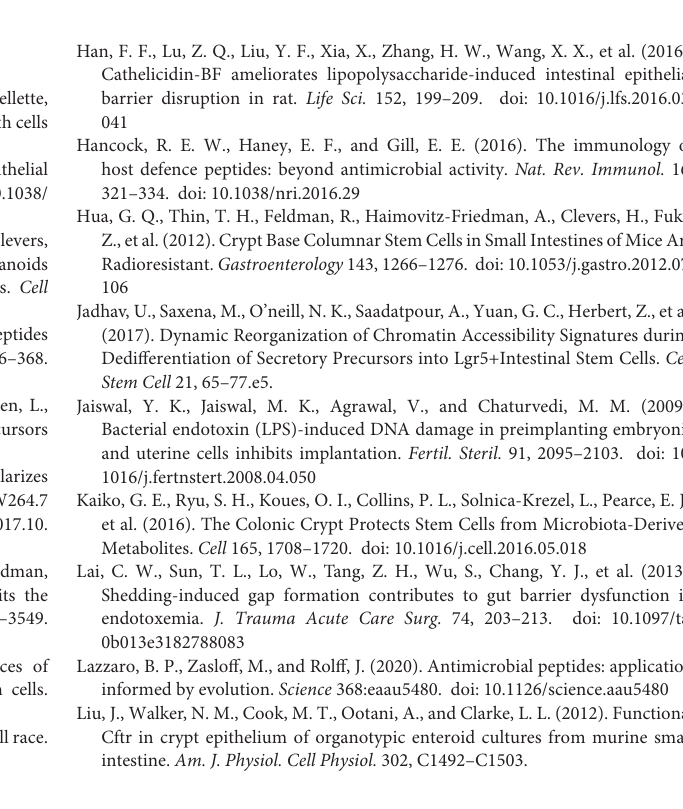
Supplementary Figure 1 | Representative image of diarrhea at 6 h after LPS injection. Severe diarrhea was observed in the LPS group from 6 h after LPS IP-injection. Supplementary Figure 2 | Responses of small intestine to LPS stimulation at 6 h after injection. (A) H&E staining of jejunum sections at 6 h after LPS injection. Scale bars, 100 µ m. (B) Gut permeability was determined by D-LA at 6 h after LPS injection. (C–G) Representative immunofluorescence images and quantification of Lgr5 + cells (scale bar, 50 µ m), Olfm4 + cells (scale bar, 100 µ m), ki67 + cells (scale bar, 100 µ m), EdU + cells (scale bar, 100 µ m) and Paneth cells (scale bar, 50 µ m) at 6 h after LPS injection. ∗∗∗ P < 0.001 by two-sided, unpaired t -test. All data represent at least three independent experiments. Supplementary Figure 3 | CWA promotes intestinal epithelial proliferation independent of Notch, Wnt/ β -catenin signaling pathways and innate AMPs. (A) RT-qPCR analysis of relative crypts mRNA expression of Wnt pathway genes in crypts. (B) RT-qPCR analysis of relative crypts mRNA expression of Notch pathway genes in crypts. (C) RT-qPCR analysis for relative crypts mRNA expression of Reg3b and Reg3g innate antimicrobials in crypts. ∗∗∗ P < 0.001 by two-sided, unpaired t -test. All data represent at least three independent experiments. Supplementary Figure 4 | Immunofluorescence and IHC analysis of γ -H2AX and SETDB1. (A) Representative immunofluorescence images of γ -H2AX expression in crypt at 6 h after LPS injection and numbers of γ -H2AX + cells in crypts at 6 h after LPS injection. (B) Representative IHC image of SETDB1 expression at 6 h after LPS injection and analysis of SETDB1 IHC intensity. ∗∗∗ P < 0.001 by two-sided, unpaired t -test. All data represent at least three independent